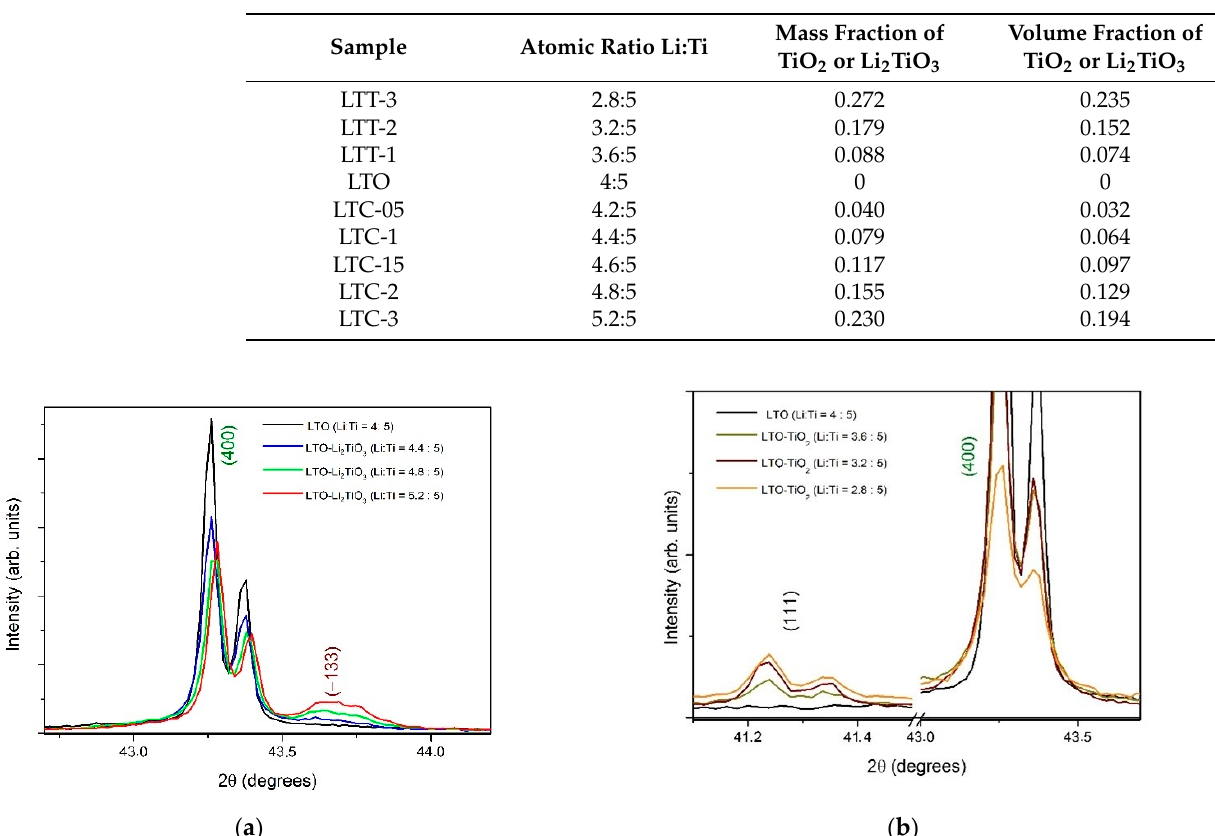
Figure 1. XRD patterns of samples synthesized at different ratios of Li:Ti in the initial mixtures: composite (b) LTC-2 (Li:Ti = 4.8:5), (c) single phase LTO (Li:Ti = 4.0:5) and (d) LTT-2 composite (Li:Ti = 3.2:5) in comparison with the patterns of pure phases (a) Li 2 TiO 3 and (e) TiO 2 (rutile). Table 1. The calculated values of relative concentrations of components in composites.